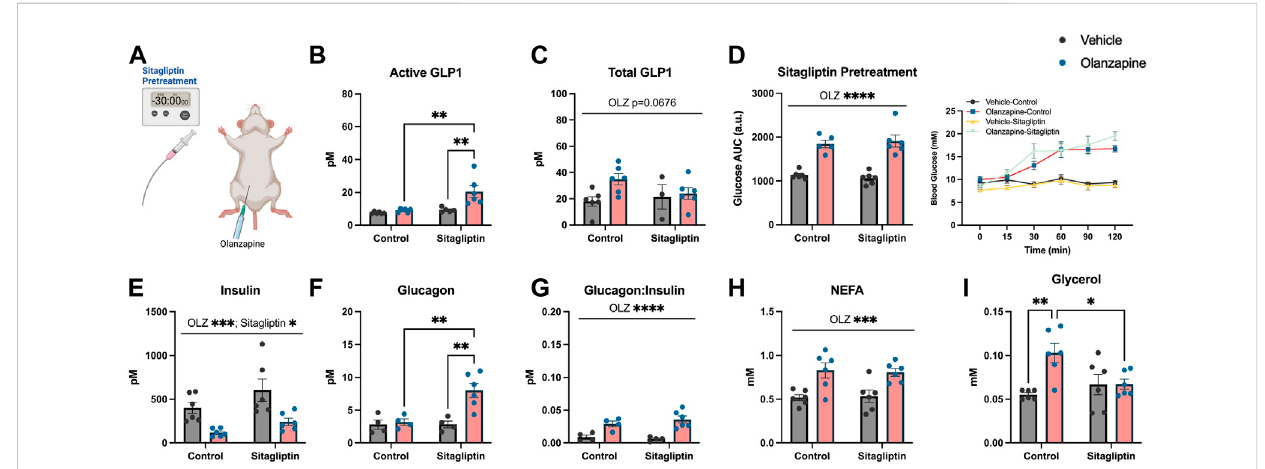
FIGURE 2 Sitagliptin pretreatment does not protect against olanzapine-induced changes in glucose homeostasis. Mice were treated with oral gavage of sitagliptin (10 mg/kg) 30 min prior to an IP injection of olanzapine (5 mg/kg) (A) ( n = 4-6 mice/group). (B, C) Active and total GLP1 were measured from serum following 120 min from injection. (D) Blood glucose was measured from the distal tail blood and area under the curve (AUC) calculated. In serum collected from cardiac blood, insulin (E) , glucagon (F) , the ratio of glucagon:insulin (G) , Non-Esteri fi ed Fatty Acids (H) , and glycerol (I) were measured. Blood glucose AUC and serum hormones/metabolites were analyzed by two-way ANOVA. Lines over graphs indicate a main effect of the describedparameterwhile barsconnectedbylinesindicateasigni fi cantdifferencebetween indicatedgroups.* p < 0.05,** p < 0.01,*** p < 0.001,**** p < 0.0001. All data are presented as mean ±